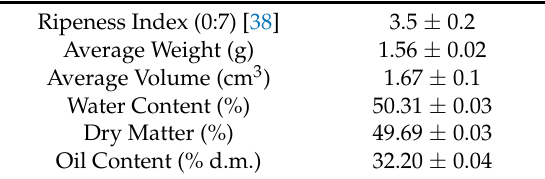
Table 8. Olive fruit